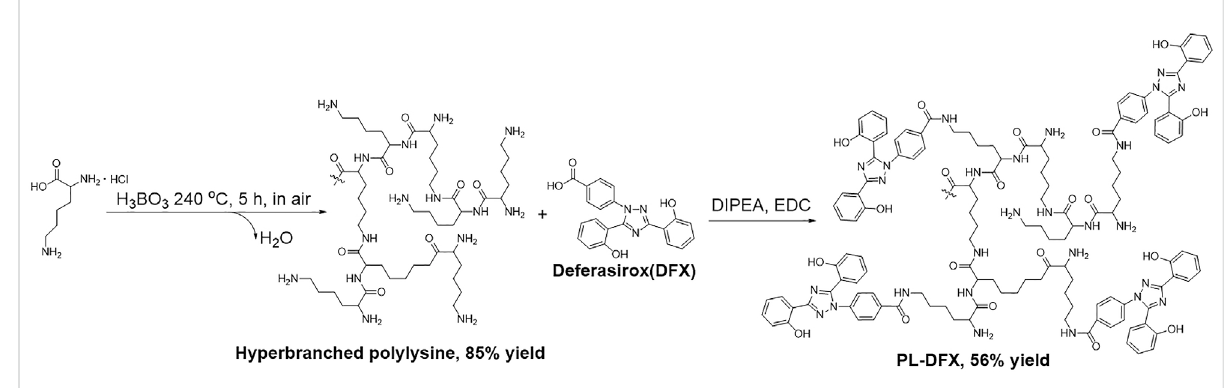
Schematic illustration of PL-DFX synthesis and